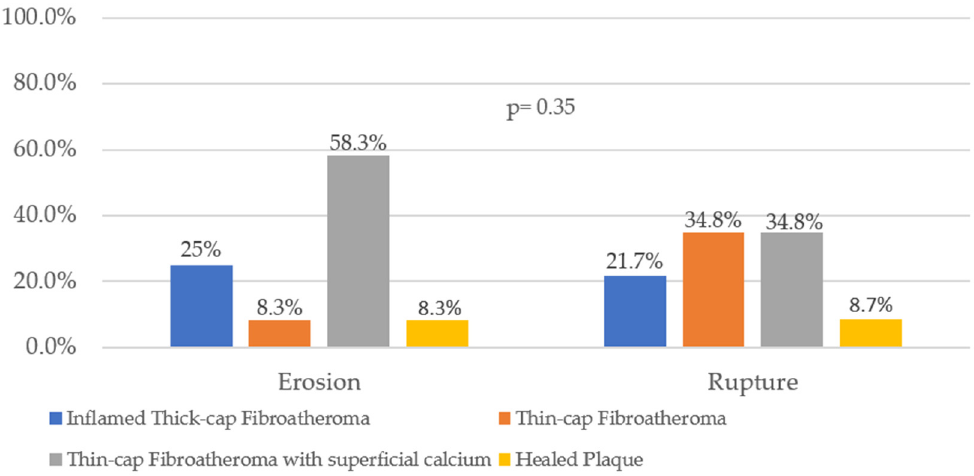
Figure 5. Underlying plaque configuration of intimal discontinuities.